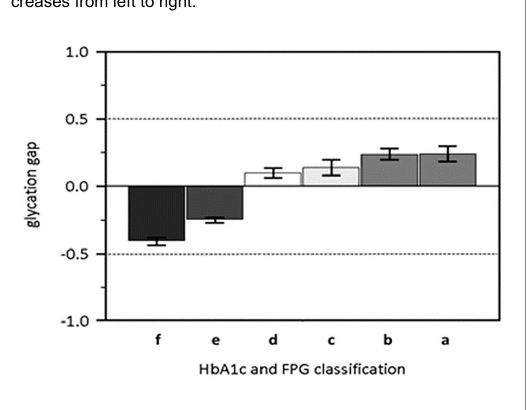
Figure 4: Glycation gap values in healthy participants, according to four baseline classifications of prediabetes defined by FPG and HbA1c (see text, [33] and [34]). Multiple combinations of FPG and HbA1c levels are used to present the glycation gap and the impair- ment of glycaemic control (abscissa). These combinations are: (a) HbA1c 6.0–6.4% and FPG 6.1–6.9 mmol/l, (b) HbA1c 6.0–6.4% and FPG 5.6–6.9 mmol/l, (c) HbA1c 5.7–6.4% and FPG 6.1–6.9 mmol/l, (d) HbA1c 5.7–6.4% and FPG 5.6–6.9 mmol/l, (e) HbA1c <6.0% and FPG <6.1 mmol/l, (f) HbA1c <5.7% and FPG <5.6 mmol/l.The six alphabetic characters represent, from left to right,